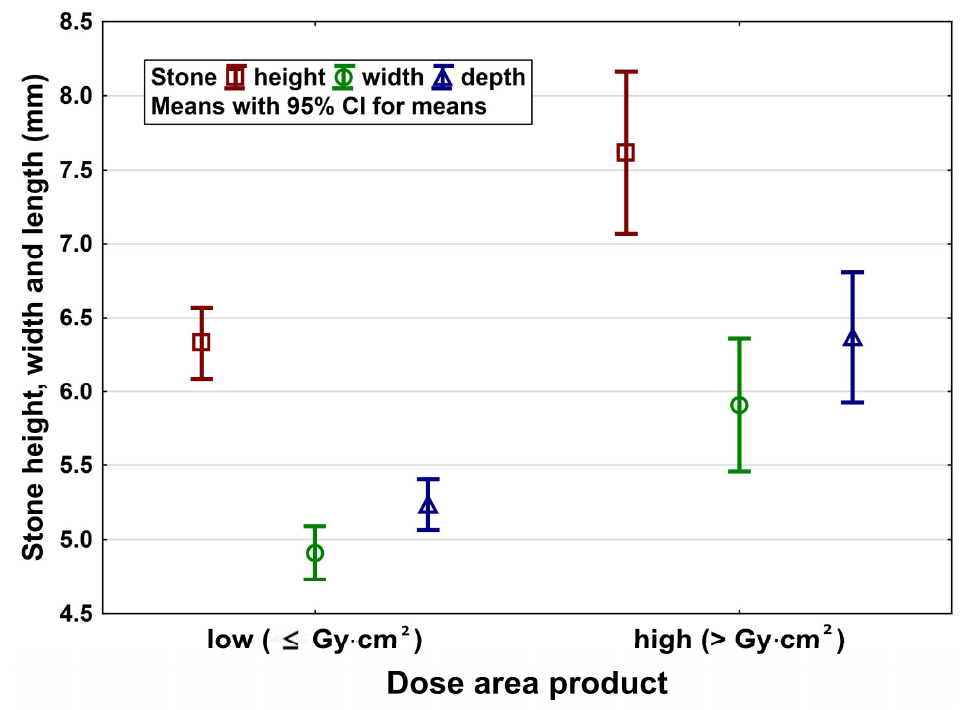
Figure 1. Stone size in width, height and depth differ significantly between patients with low and high dose area product.